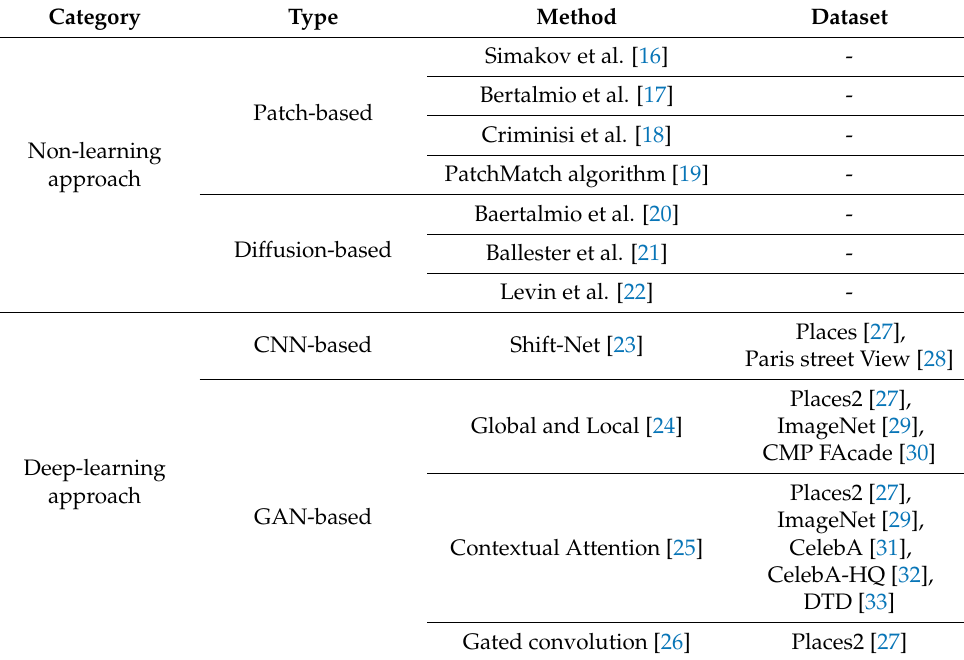
Table 1. List of various image inpainting methods in the field of computer vision.